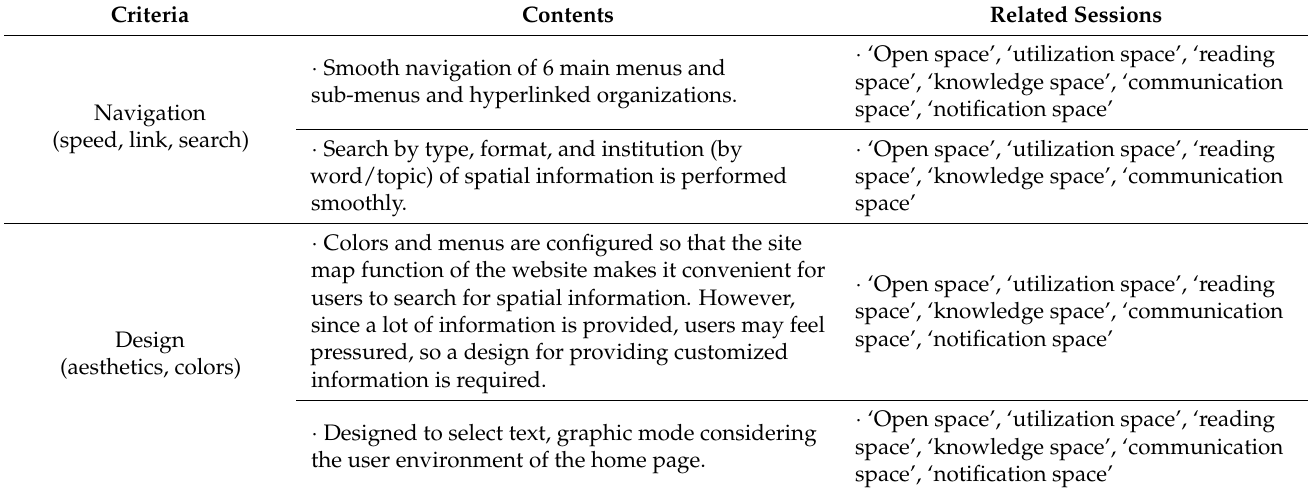
Table 5. Website usability evaluation of NSDIP.